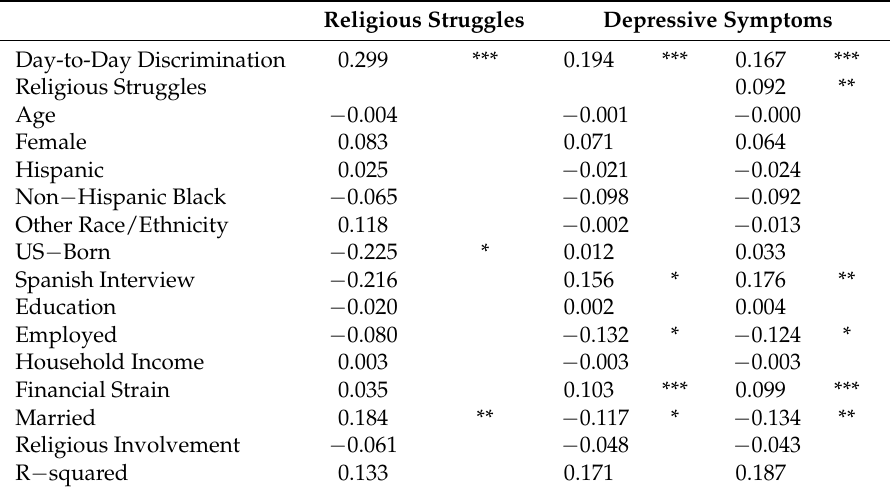
Table 3. OLS Regression of Religious Struggles and Depressive Symptoms ( n =